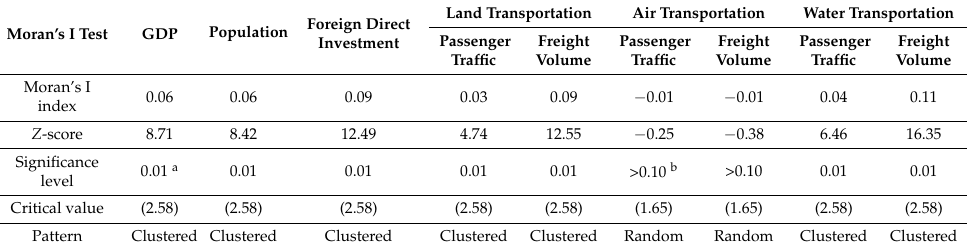
Table 1. Moran’s I test of the variables in China.